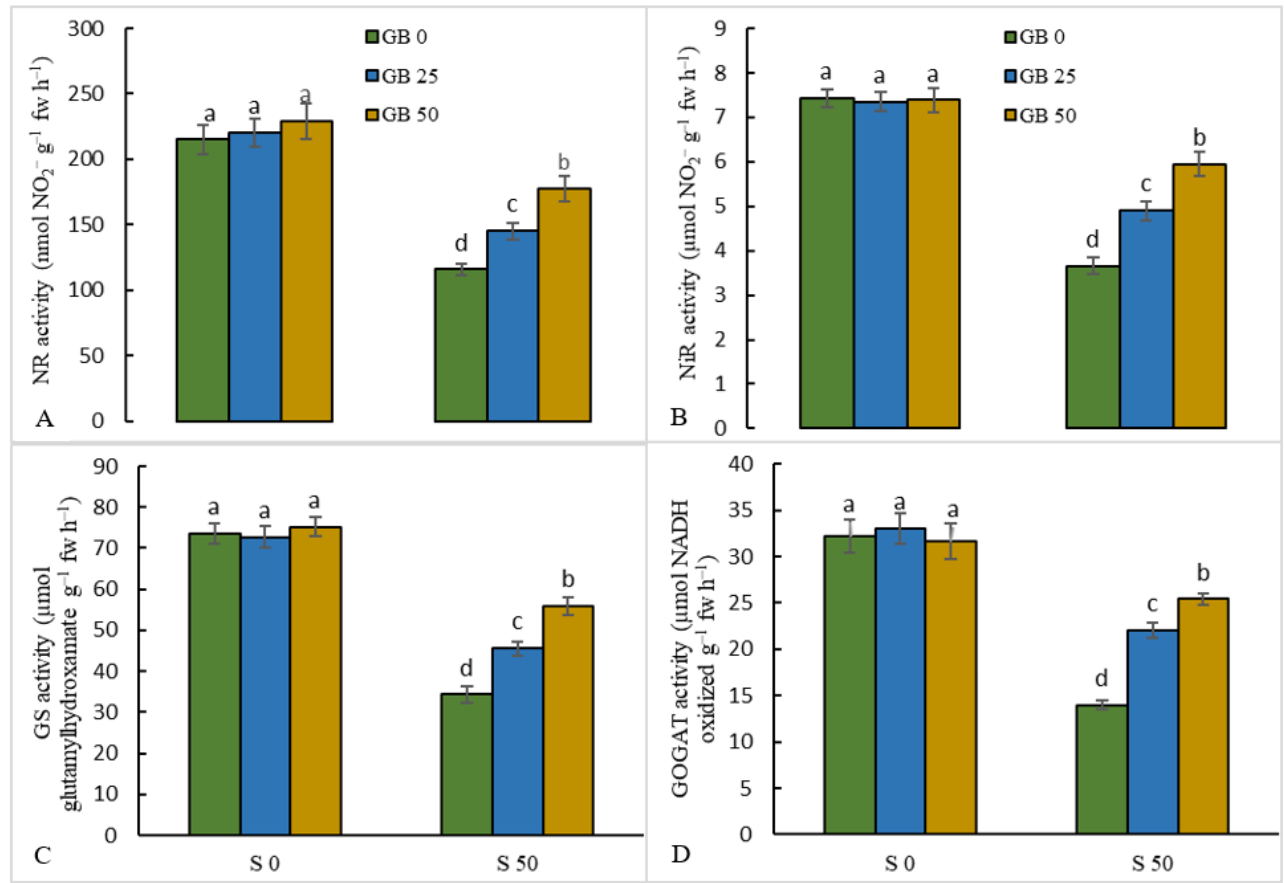
Figure 5. Effect of glycine betaine (GB, 0, and 50 mM) on the activity of N-metabolism enzymes (nitrate reductase (NR, ( A )), nitrite reductase (NiR, ( B )), glutamine synthetase (GS, ( C )), glutamate synthase (GOGAT, ( D ))) in stevia leaves under NaCl (0, 25, and 50 mM) treatment. Values (means ± SD, n = 6) followed by the same letter are not significantly different ( p < 0.05; Duncan test).